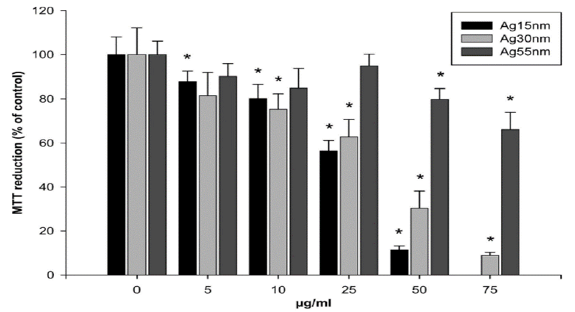
Figure 23. Effect of AgNPs concentration on mitochondrial metabolism (MTT assay) in murine alveolar macrophages treated with AgNPs for 24 h. The data were expressed as means ± SD ( n = 3). p < 0.05 was considered significant. Reproduced from [215] with permission of the American Chemical Society.